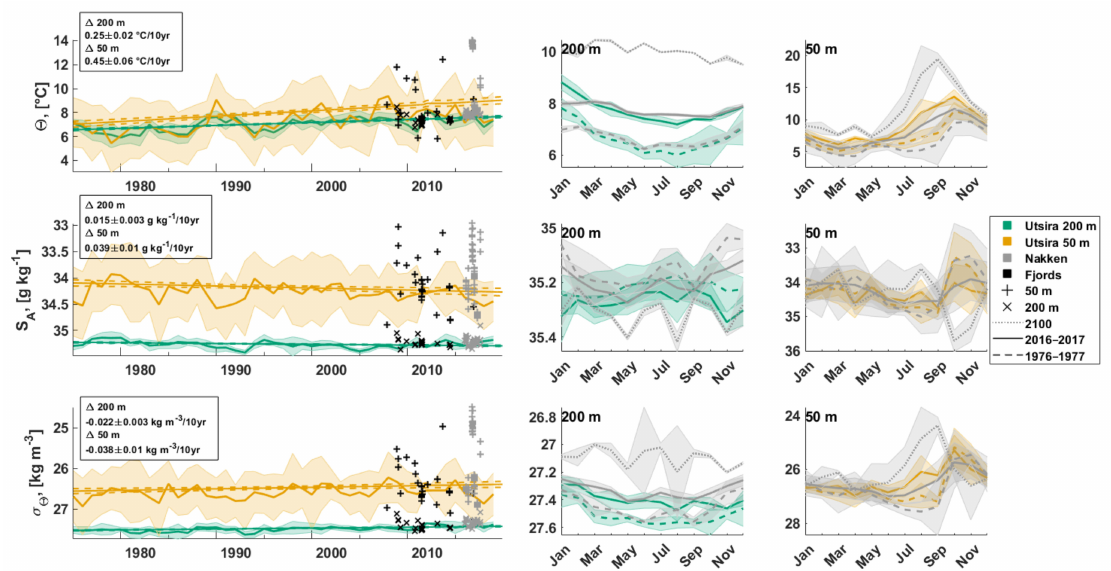
Figure 10. Temperature (first row), salinity (second row) and density (third row) at Utsira coastal station (color) ©Havforskningsinstituttet, Korsfjorden-Langenuen-Bømlafjorden area (black) ©Havforskningsinstituttet, and at Lan- genuen/Nakken (gray). The first column shows Utsira annual mean ± 1 σ and linear fit with 95% confidence for 1975–2020 at 50 m (orange line) and at 200 m (green line) depths and individual measurements inside the fjord system at 50 m (plus signs) and 200 m (cross signs) depths. The second column shows the annual cycle at 200 m depth, and the third column the annual cycle at 50 m depth. In the second and third columns, the dashed line shows the average year ± 1 σ for Utsira for years 1976–1977, the solid line shows the average year ± 1 σ for Utsira 2016–2017, and measurements from Nakken and dotted gray line is the linear estimation at Nakken for the year